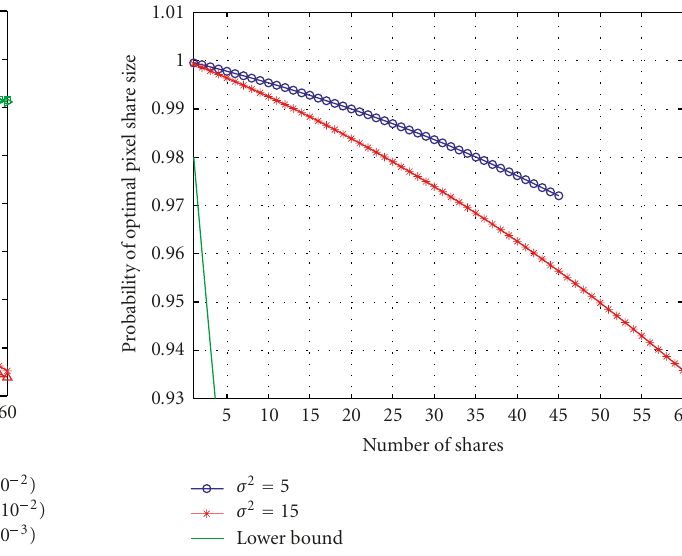
(cid:26) n | u |≤| x − x |} as a function of the number of shares n 0 k k = 0